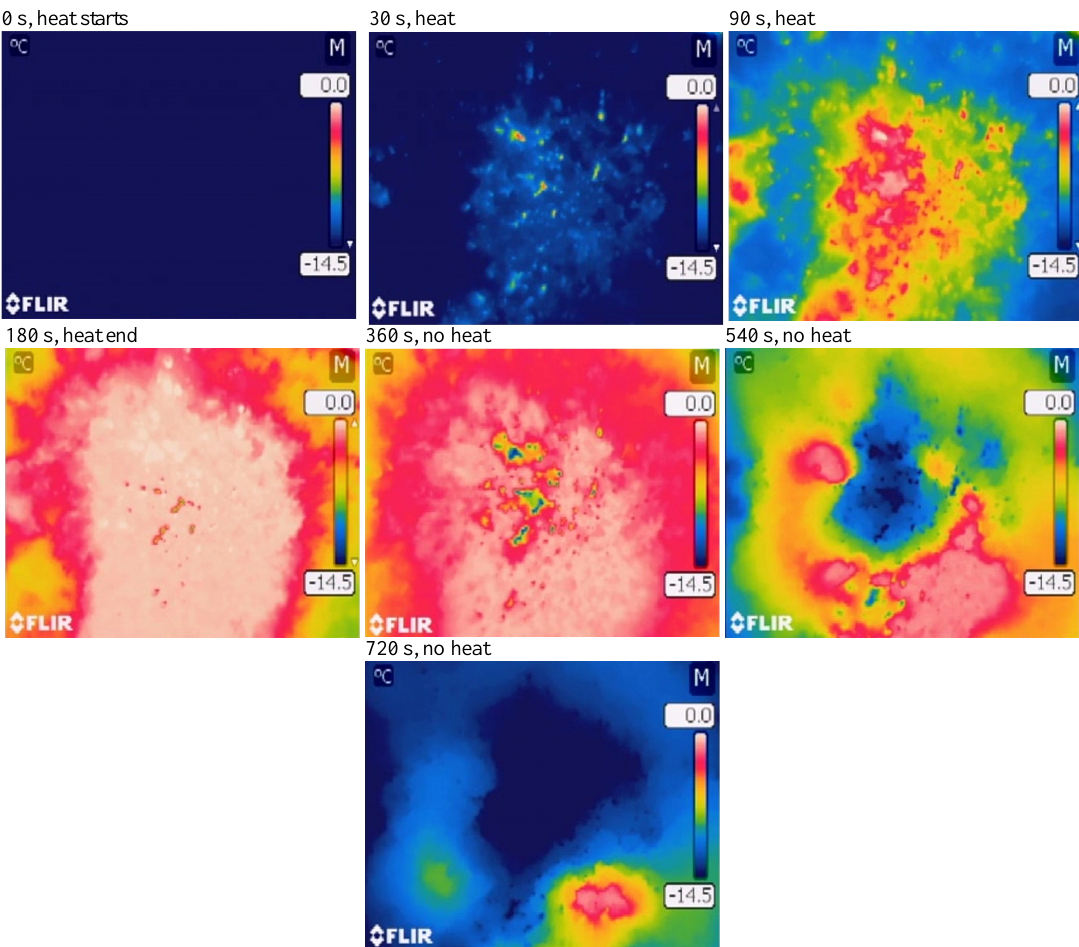
Fig. 7. Seven frames of video from a 2cm thick slice of a layer of polycrystals. The layer has crystals with extent to 6mm and density of 270kgm − 3 . Heat was applied behind the sample from 0 to 180s. Sample width in each image is ∼ 10cm.